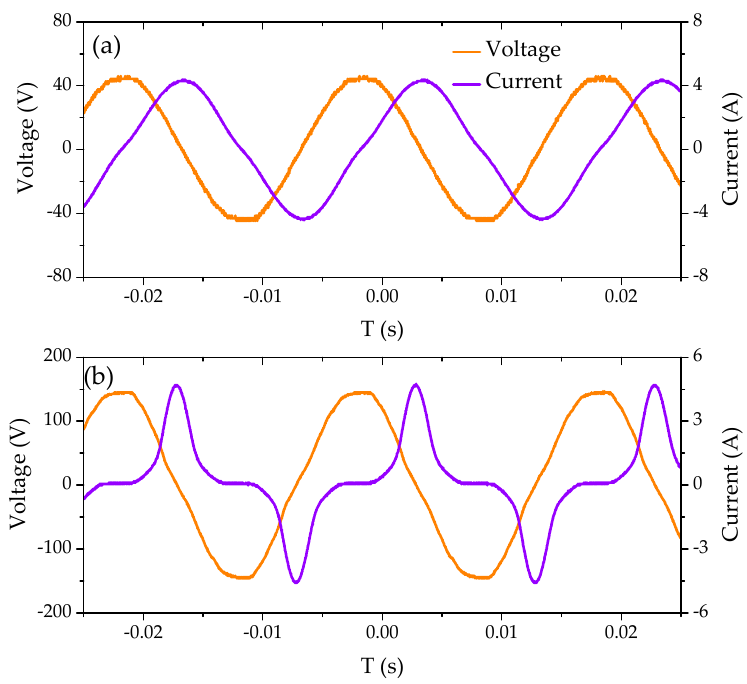
Figure 10. Voltage-current shapes for di ff erent DC control currents ( a ) 8120 mA, ( b ) 0 mA. The distorted behavior of the current is assigned to the higher THD coe ffi cient. The THD coe ffi cients for di ff erent DC currents are represented in Figure 9b. It is observed that the THD coe ffi cient is higher for the lower control DC current.